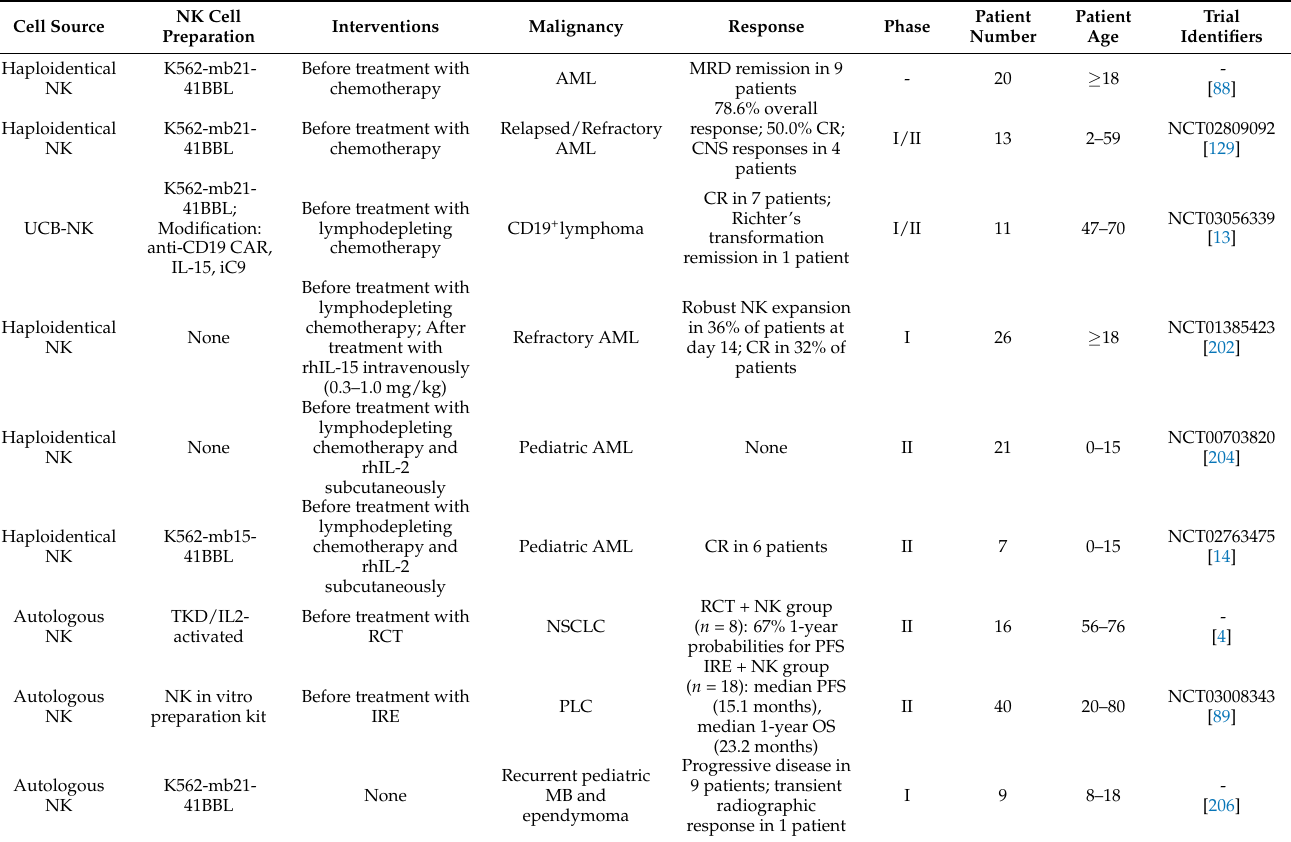
Table 3. Recent clinical results of NK cell infusions (2019–2021).